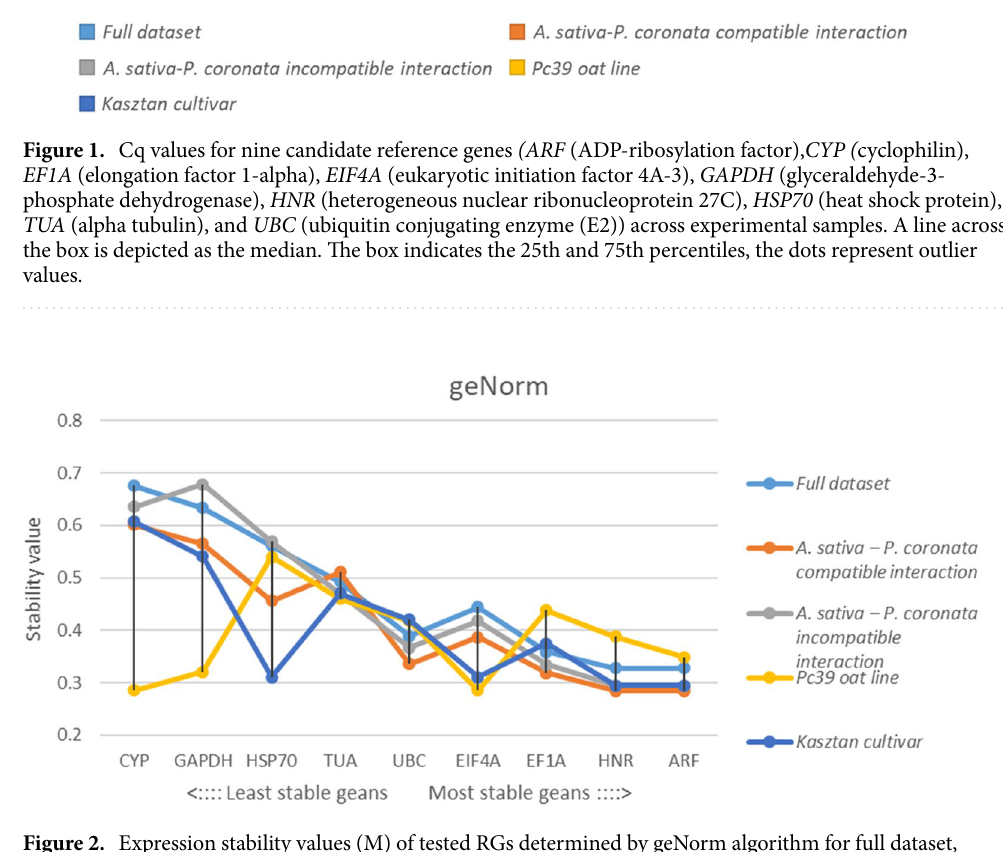
Figure 2. Expression stability values (M) of tested RGs determined by geNorm algorithm for full dataset, compatible interaction dataset, incompatible interaction dataset, Pc39 oat line dataset and Kasztan cultivar dataset. Low M values indicate high expression stability across samples